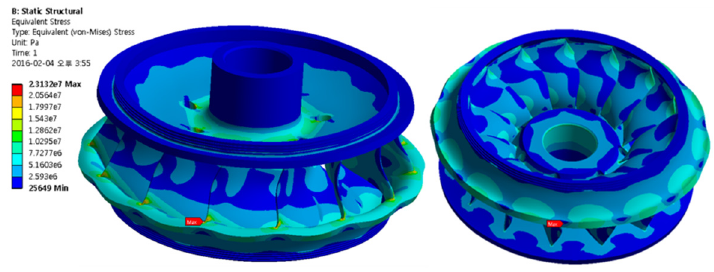
Figure 19. Stress distribution on the runner.